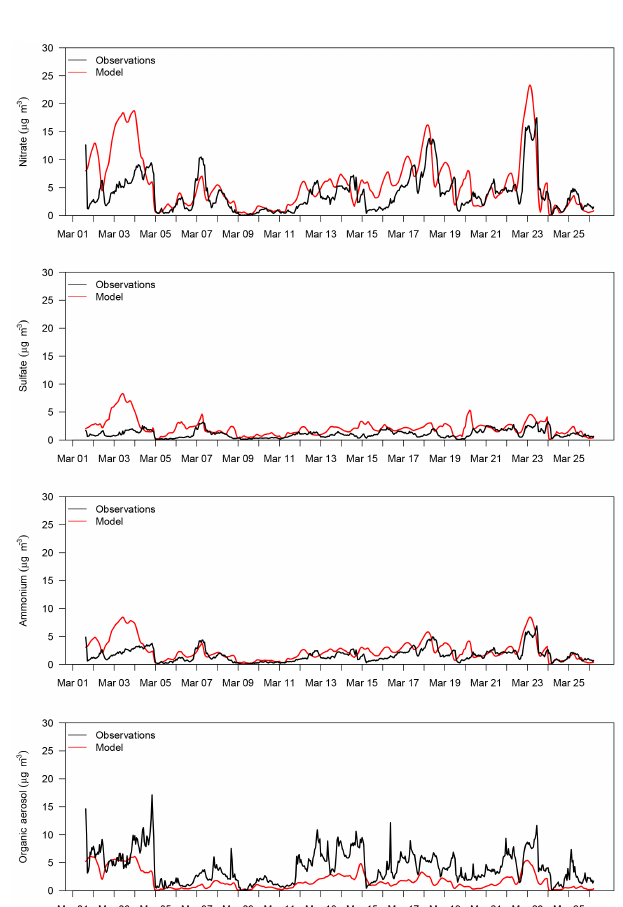
Figure 4. Comparison of observed and modelled nitrate, ammo- nium, sulfate and organic aerosol at Payerne for March